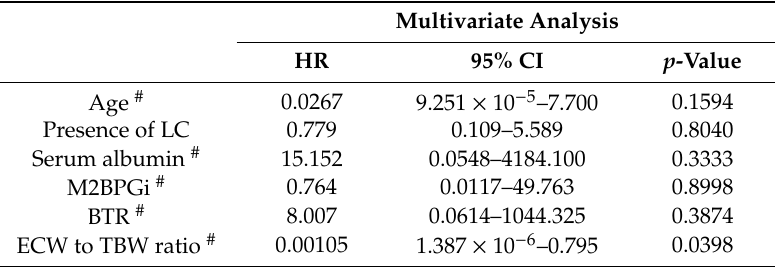
Table 4. Multivariate analyses of factors linked to the walking speed decline ( < 0.8 m / s).